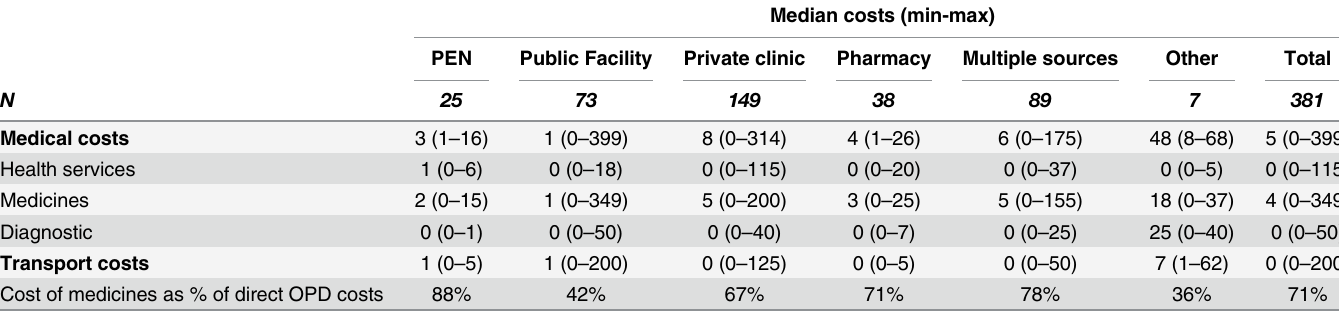
Table 7. Treatment costs in US Dollars by source of treatment for the last outpatient visit §